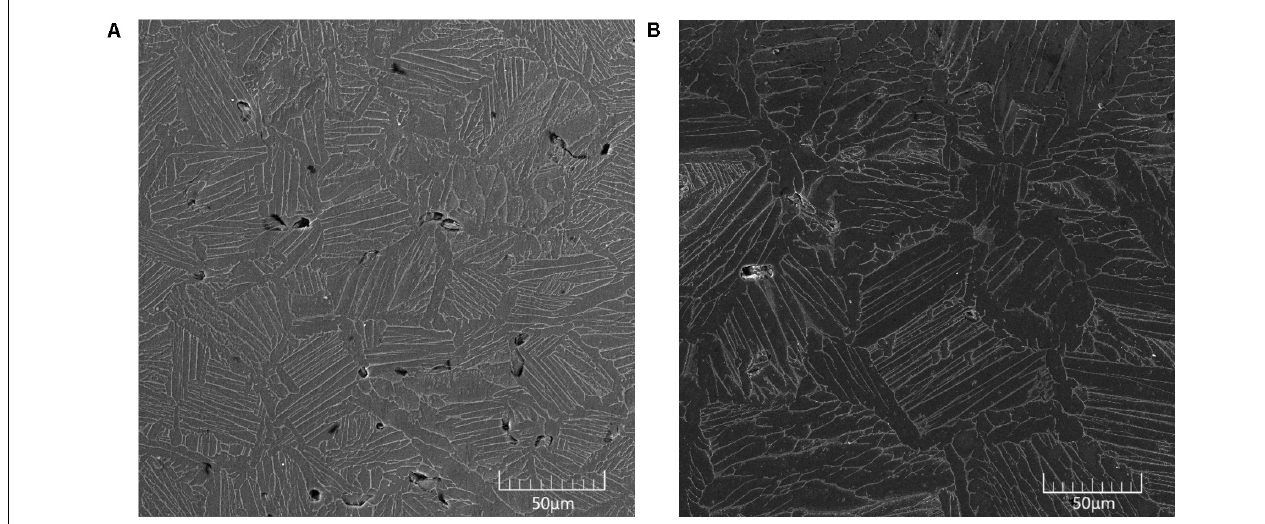
FIGURE 6 | Transformation of porosity in sintered Ti80 alloy depending on sintering temperature: (A) 1100 ◦ C 4 h and (B) 1250 ◦ C 4 h (SEM).